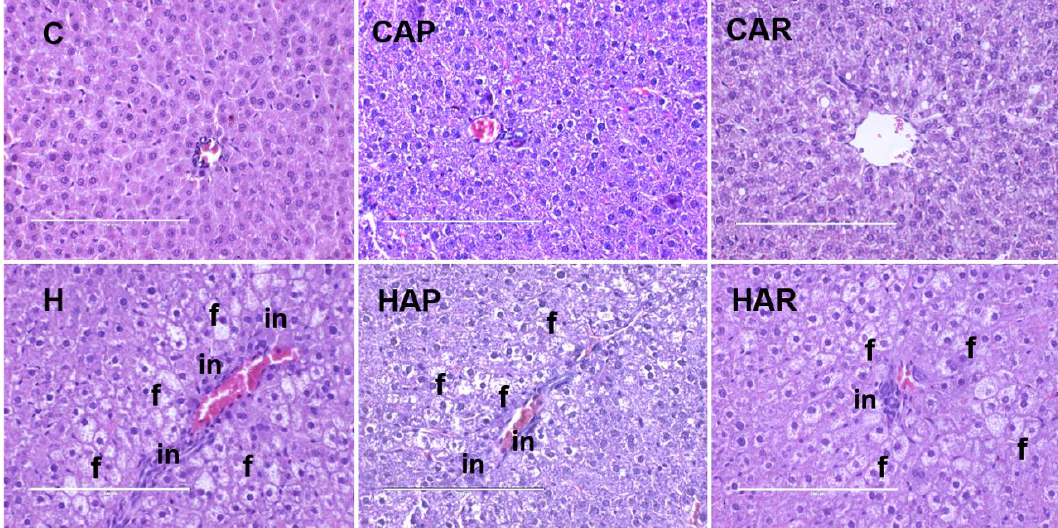
Figure 5. Hematoxylin and eosin staining of hepatocytes (magnification × 20; Scale bar = 200 µ m) showing inflammatory cells (marked as “in”) and hepatocytes with fat vacuoles (marked as “f”) in rats fed corn starch diet (C), corn starch diet + achacha pulp (CAP), corn starch diet + achacha rind (CAR), high-carbohydrate, high-fat diet (H), high-carbohydrate, high-fat diet + achacha pulp (HAP), and high-carbohydrate, high-fat diet + achacha rind (HAR).